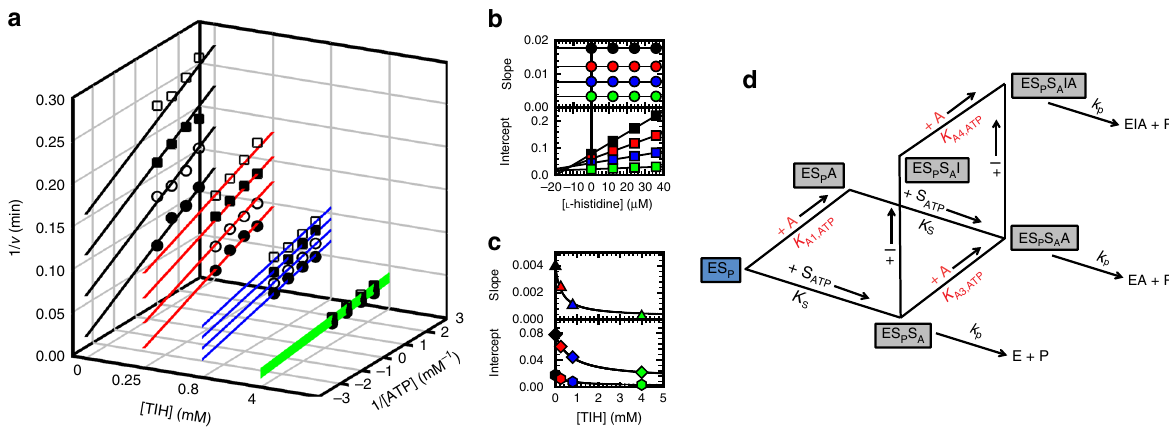
Fig. 3 L -His inhibition kinetics in the presence of TIH. a Four double-reciprocal plots showing linear uncompetitive inhibition patterns determined for L -His in the presence of 0 ( black ), 0.25 ( red ), 0.8 ( blue ) and 4 ( green ) mM TIH, at fi xed variable concentrations of ATP. Results are representative of two independent experiments. Points are experimental data obtained with 0 ( black circles ), 12 ( white circles ), 24 ( black squares ) and 36 (white squares) µ M L -His. Lines are the best fi t of each uncompetitive pattern data set to Eq. 5 in Methods section. b Secondary replot of the slopes ( circles ) and intercepts ( squares ) of the data shown in a . c Tertiary replots of the slopes ( top panel ) and intercepts ( lower panel ) of the data shown in b . Slope of the intercept ( triangles ), intercept of the intercept ( diamond s) and intercept of the slope ( hexagons ). Lines are the best fi t to Eq. 7 in Methods section. d Kinetic model for a combination of uncompetitive inhibition and non-essential activation. The complexes in boxes are in equilibrium. The blue box indicates that this complex is always present in the assay. E, Enzyme; S A , ATP; S P , PRPP; A, TIH; I, L -His; P, Product